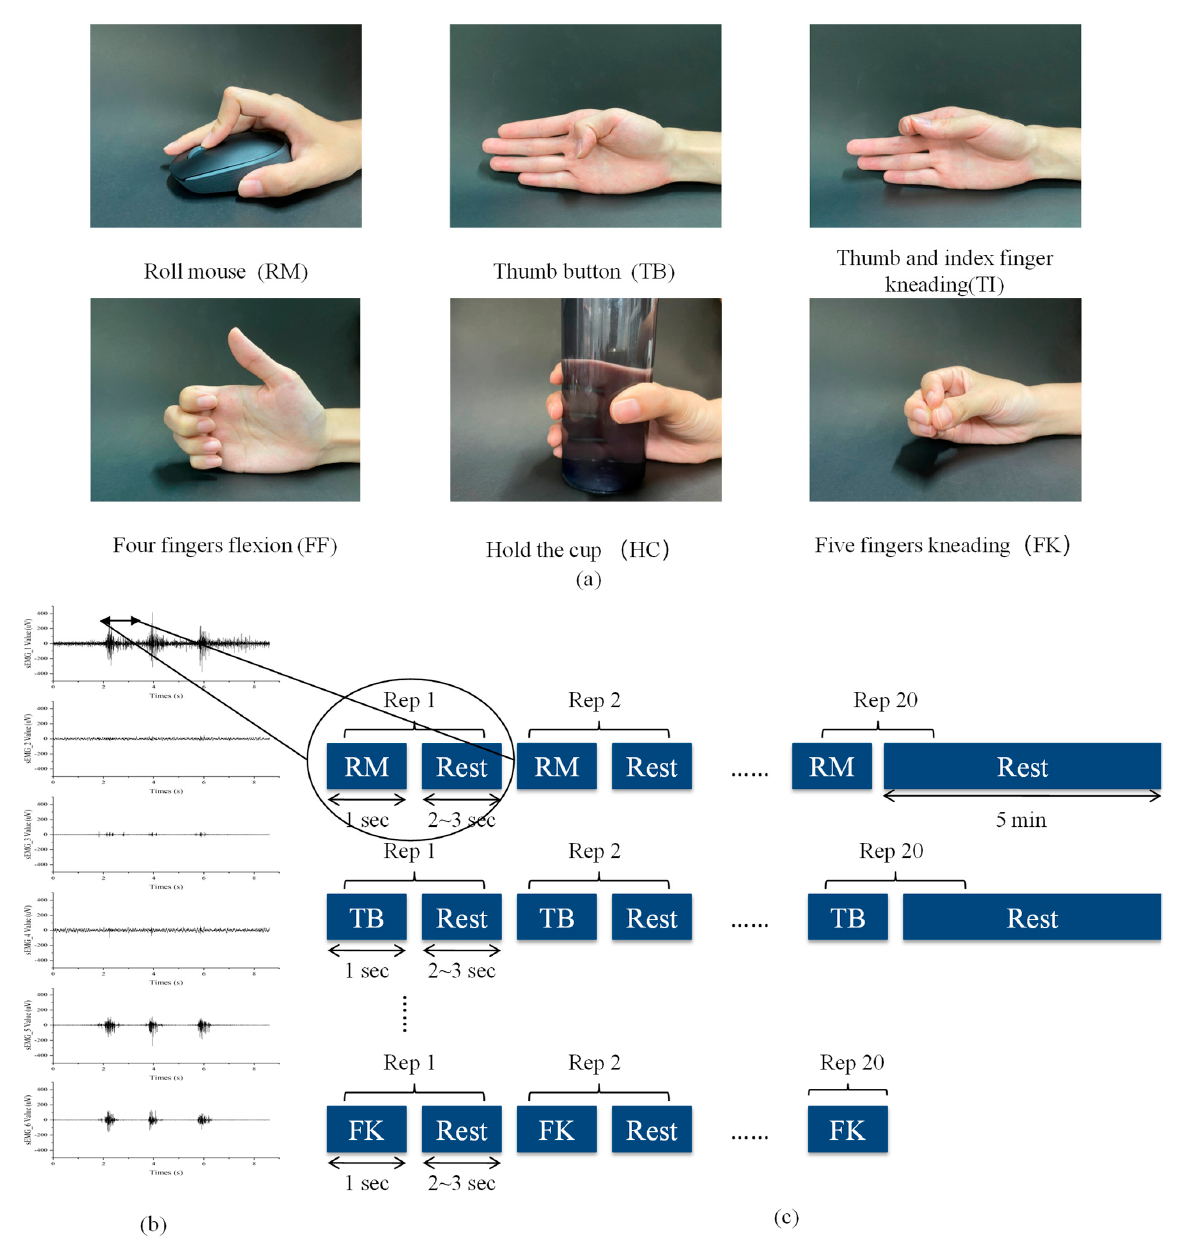
Figure 1. Experimental procedure for the acquisition of sEMG signals. ( a ) Acquisition settings: each person independently performs 6 hand-gestures(RM, TB, TI, FF, HC and FK). The 6 hand-gestures represent the daily hand functions of using mouse: pressing the thumb button, pinching objects with the thumb and index finger, closing five fingers and grasping cylindrical or spherical objects. ( b ) Raw EMG signal of RM hand-gesture. ( c ) Time diagram of the experimental Table 1. Time features extracted from the EMG signal.